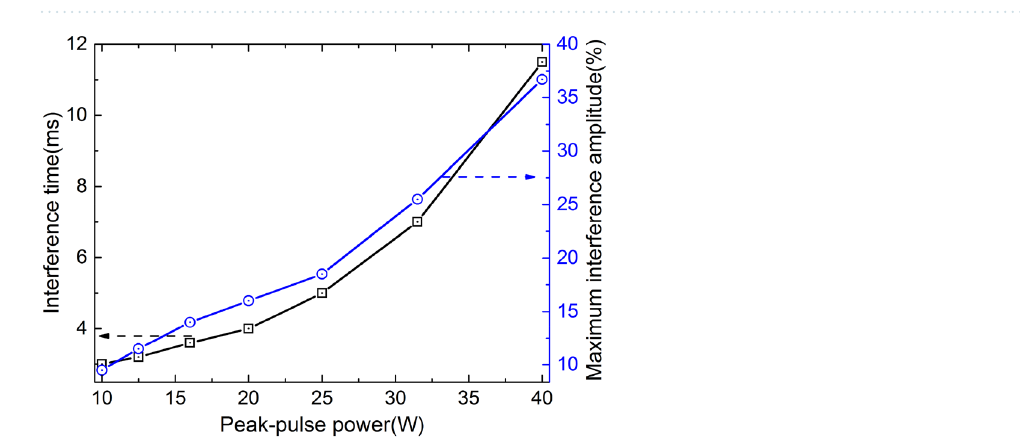
Figure 5. Output signals of the GaN-HEMT power amplifier observed by the oscilloscope when microwave pulses were injected into the output port.